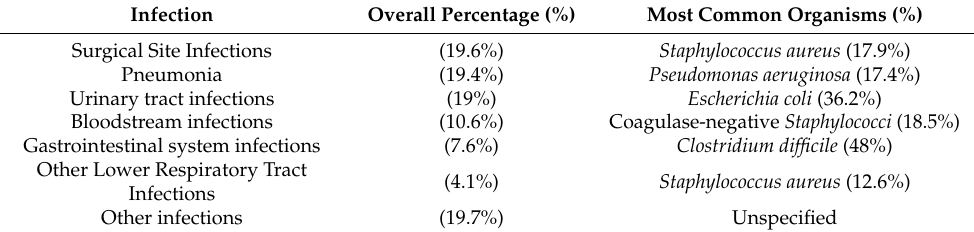
Table 1. Common hospital-acquired infections and the most common bacteria associated with them